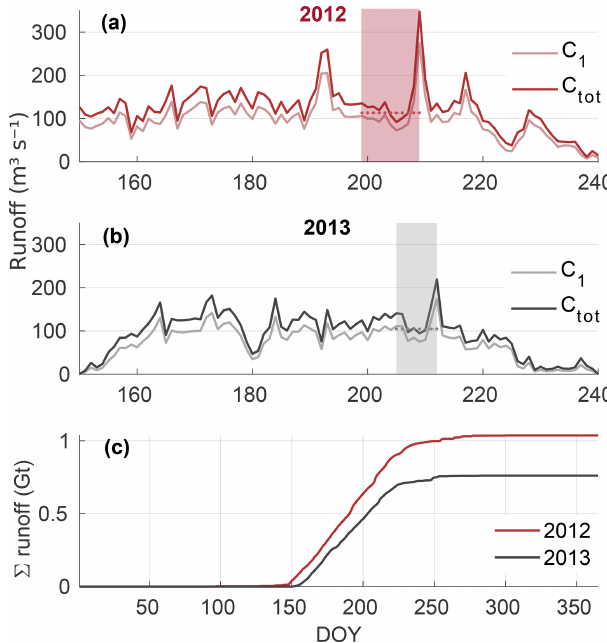
Figure 9. Characteristic plume heights obtained from the line– plume model. NBD (solid lines) and MHD (dotted lines) are ob- tained for 2012 (red) and 2013 (grey). Dashed horizontal lines mark the depth of the jet core observed from water velocity observa- tions in 2012 and 2013 (Fig. 7). The top x axis represents the sub- glacial discharge flux applied through a channel width ( W ) of 90m. The blue vertical line shows the subglacial runoff estimate (from RACMO2.3) averaged over the 5d prior to the velocity measure- ments in the fjord each year (which were approximately the same: 101 . 7 ± 5 . 7m 3 s − 1 in 2012 and 101 . 9 ± 13 . 4m 3 s − 1 in 2013). The standard deviation of subglacial discharge during these 5d is repre- sented by the red (grey) shaded region for 2012